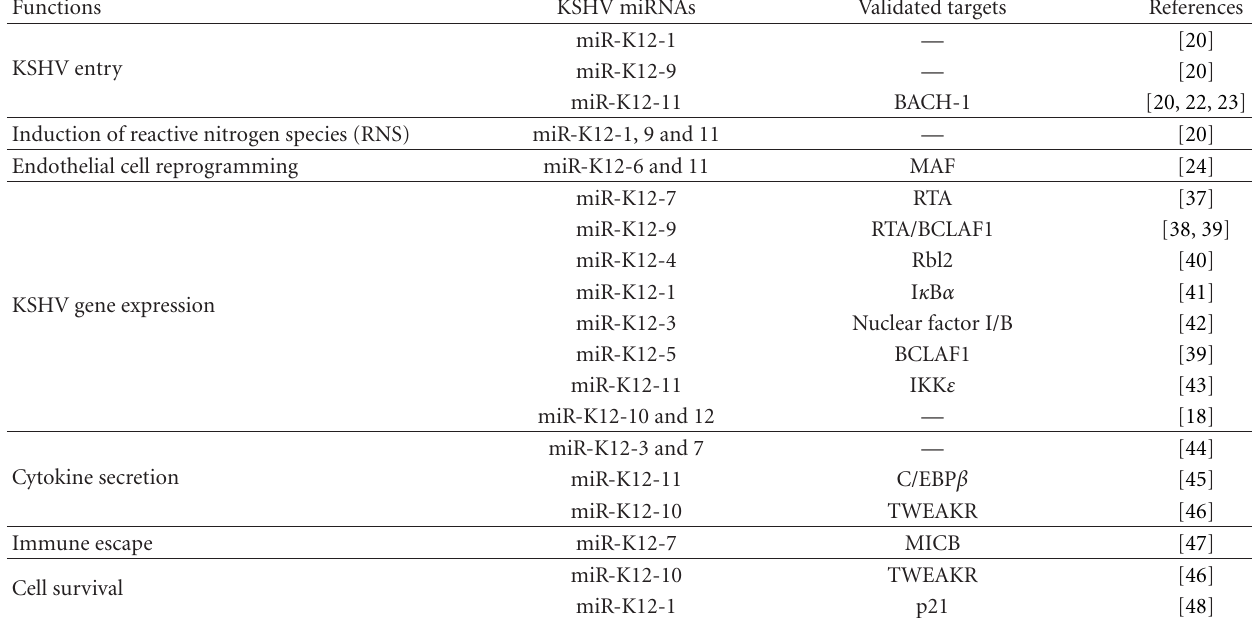
Table 1: Overview of KSHV miRNAs regulatory functions and